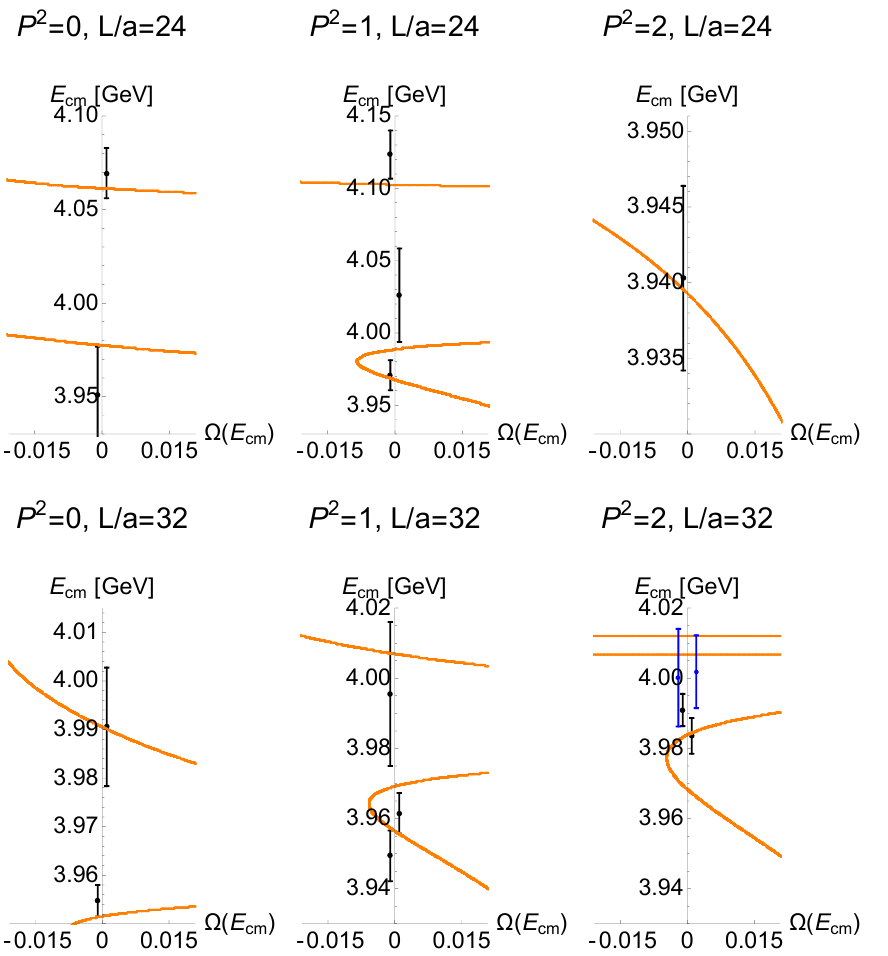
Figure 13 . The function Ω( E cm ) (defined in eq. (C.1)) for the resulting scattering matrix of the coupled channels D ¯ D − D s ¯ D s (8.14) is given by the orange line. The observed eigen-energies are given by the circles: the black levels are employed to fit the parameters (8.14), while the blue circles are